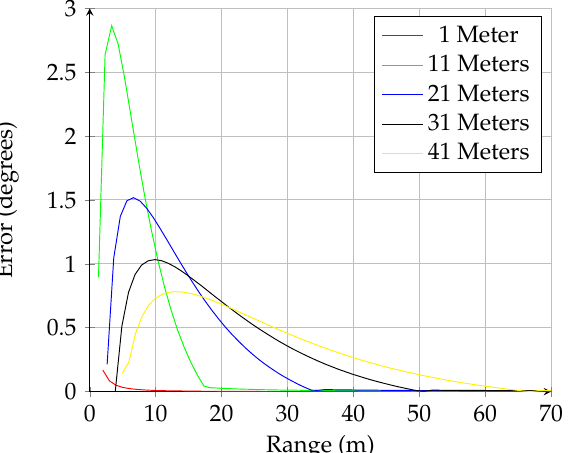
Figure 10. Difference between the analytical model presented in this work and previous models using the small-angle approximation for UGV mounted sensors. The error for different sensor mount heights is shown, with the increase in error shown for sensors at higher elevation